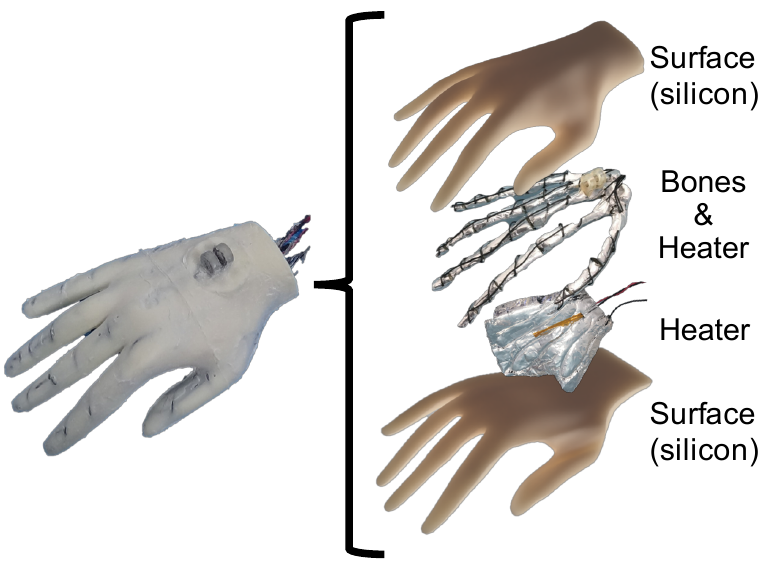
Figure 2. The structure of the developed human-mimetic robotic hand.